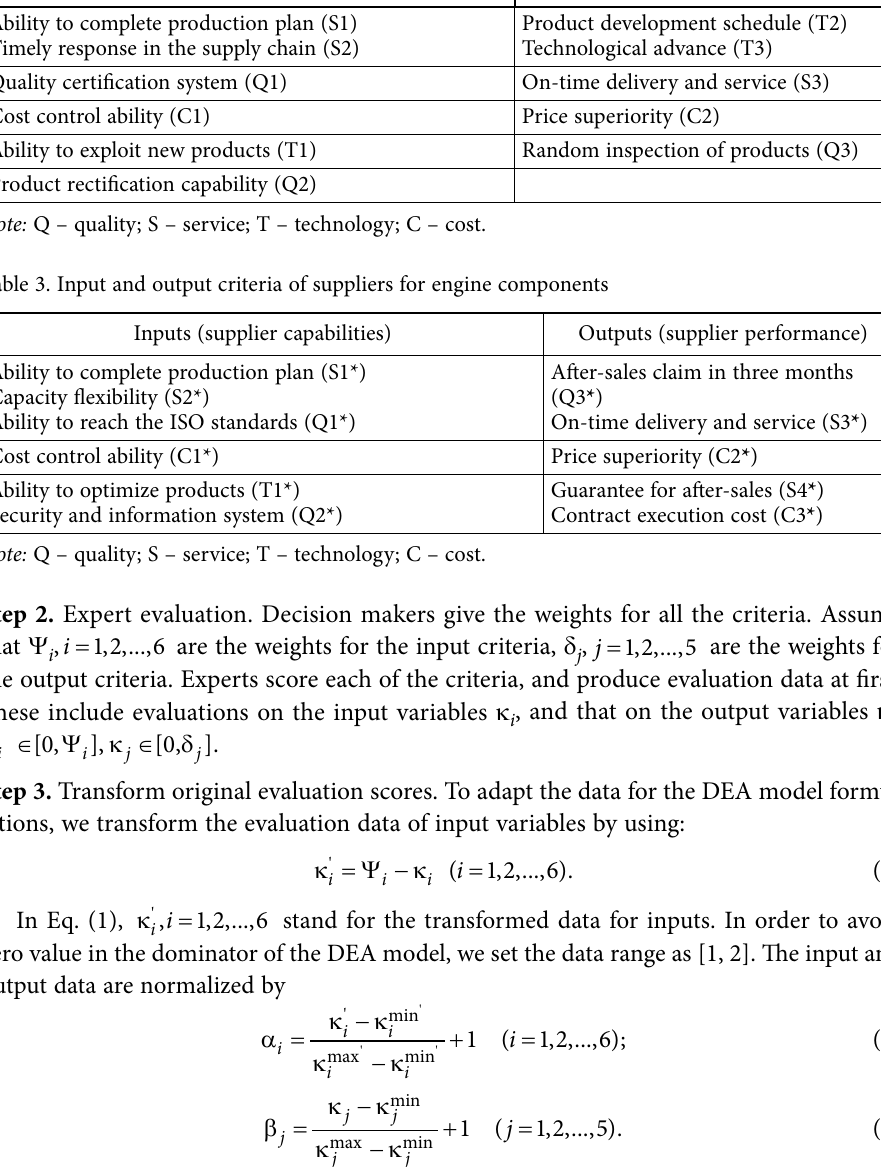
Table 2. Input and output criteria of suppliers for sensor components Inputs (supplier capabilities)